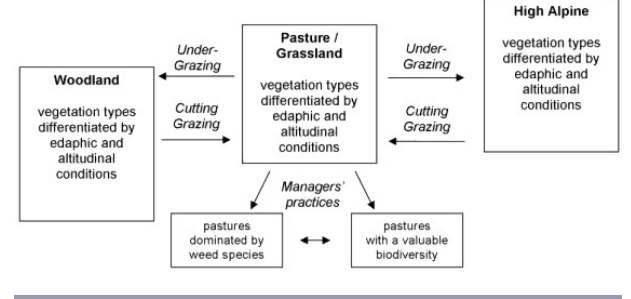
Fig. 2 . Different vegetation compositions as system states and drivers of change between them.